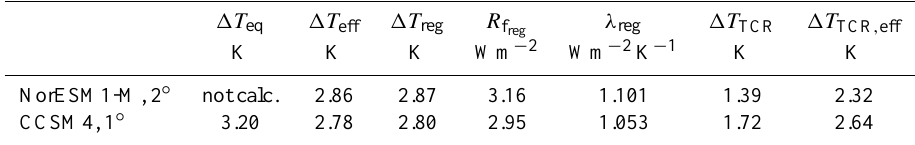
Table 1. Different estimates of climate sensitivity of the NorESM1-M with 2 ◦ resolution. Data for the CCSM4 with 1 ◦ resolution included for comparison are provided by Bitz et al. (2012). Symbols are explained in the main text; see also Fig. 1. 1T eq 1T eff 1T reg R f λ reg 1T TCR 1T TCR , eff reg K K K Wm − 2 Wm − 2 K − 1 K K NorESM1-M, 2 ◦ not calc.